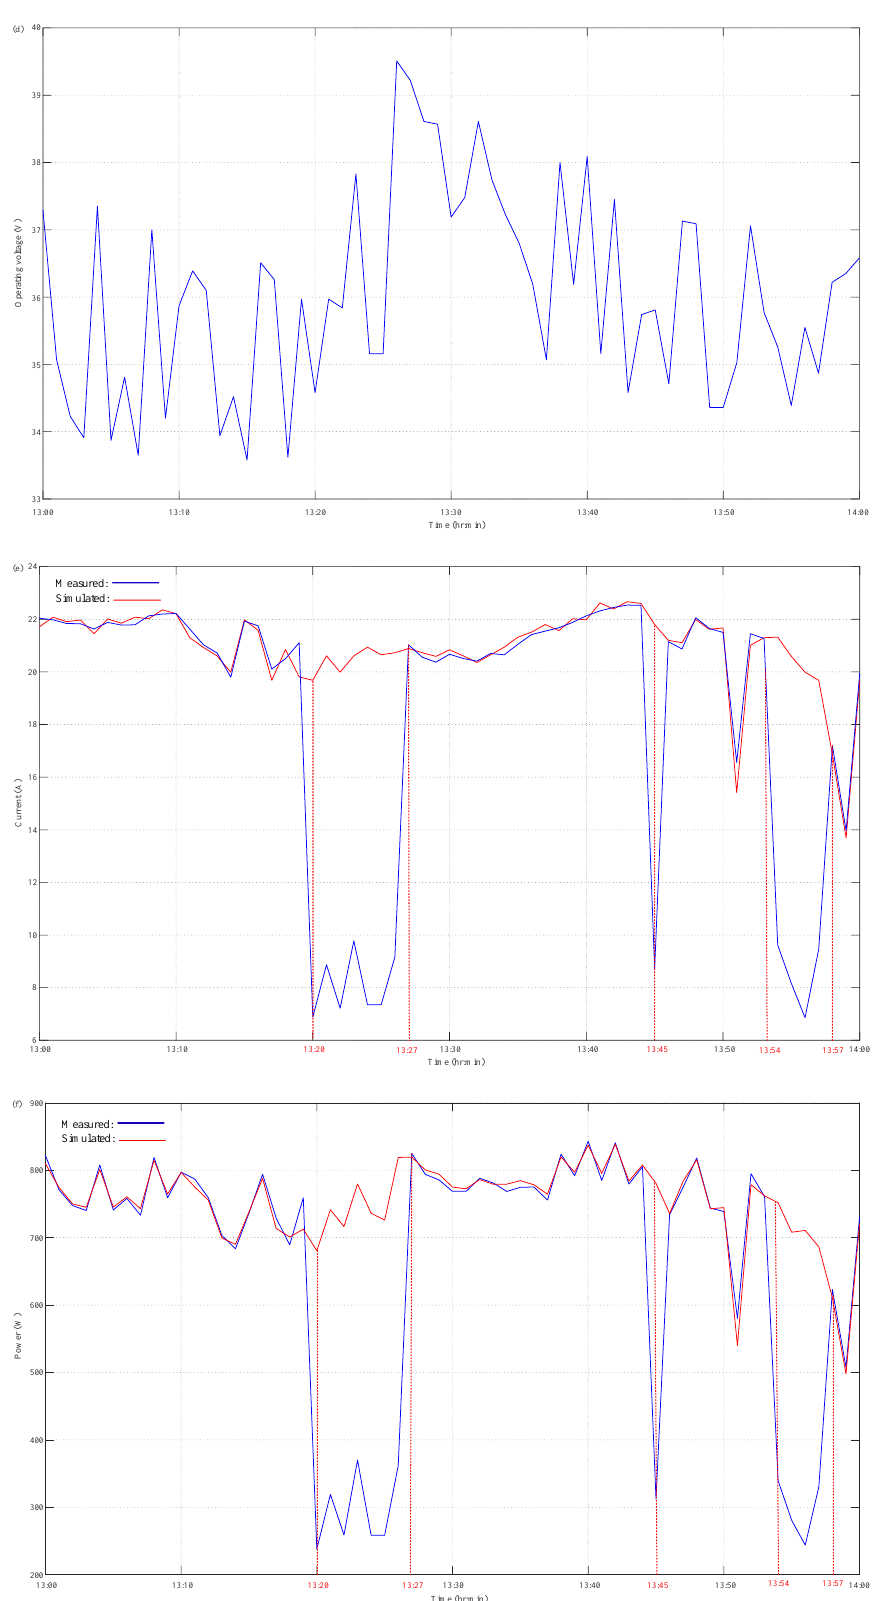
Figure 9. Measured results of PVEFD system on 19 November 2022: ( a ) covered/uncovered operation; ( b ) irradiance; ( c ) cell temperature; ( d ) voltage; ( e ) output current; ( f ) output power.